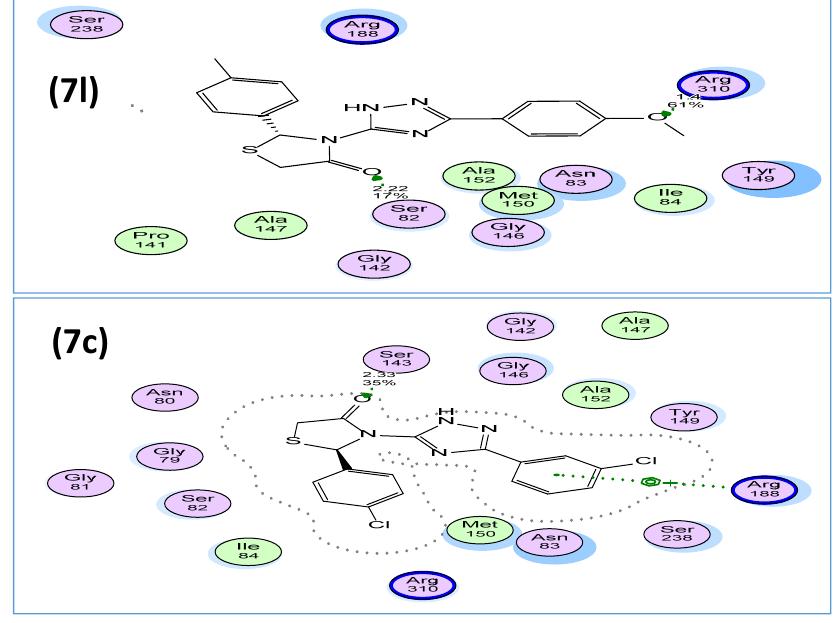
Figure 5. 2D binding mode interaction and residues involved in the recognition of moderate active Compounds 7l and 7c into the MurB binding site interaction showing the percentage of hydrogen bonds.